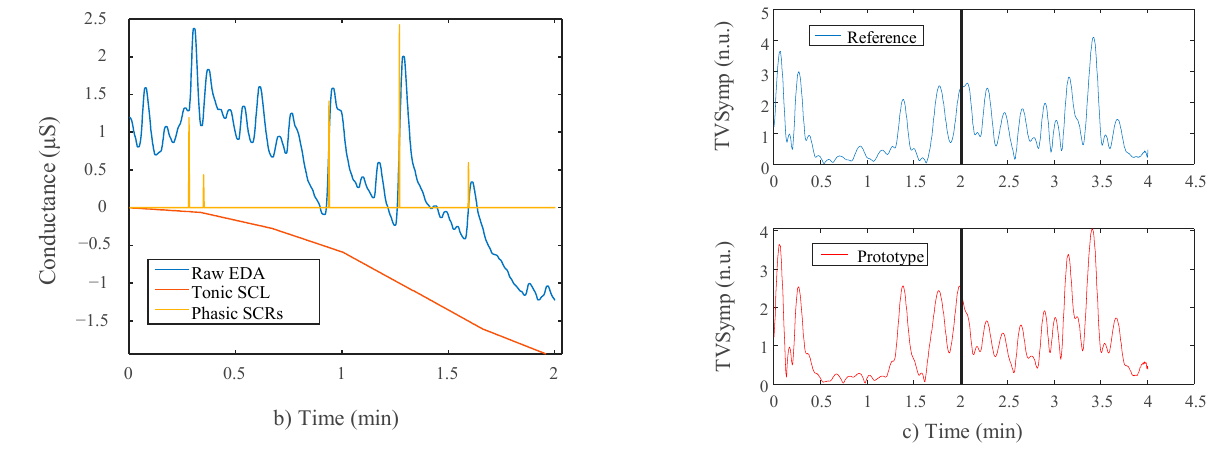
Figure 3. ( a ) Timeline illustrating the time epochs extracted from raw signal for each respetive analysis; ( b ) EDA time domain indices, blue (raw EDA), red (tonic SCL), yellow (NS.SCRs); ( c ) TVSymp frequency EDA analysis for prototype and reference device prior to and after stimulation.